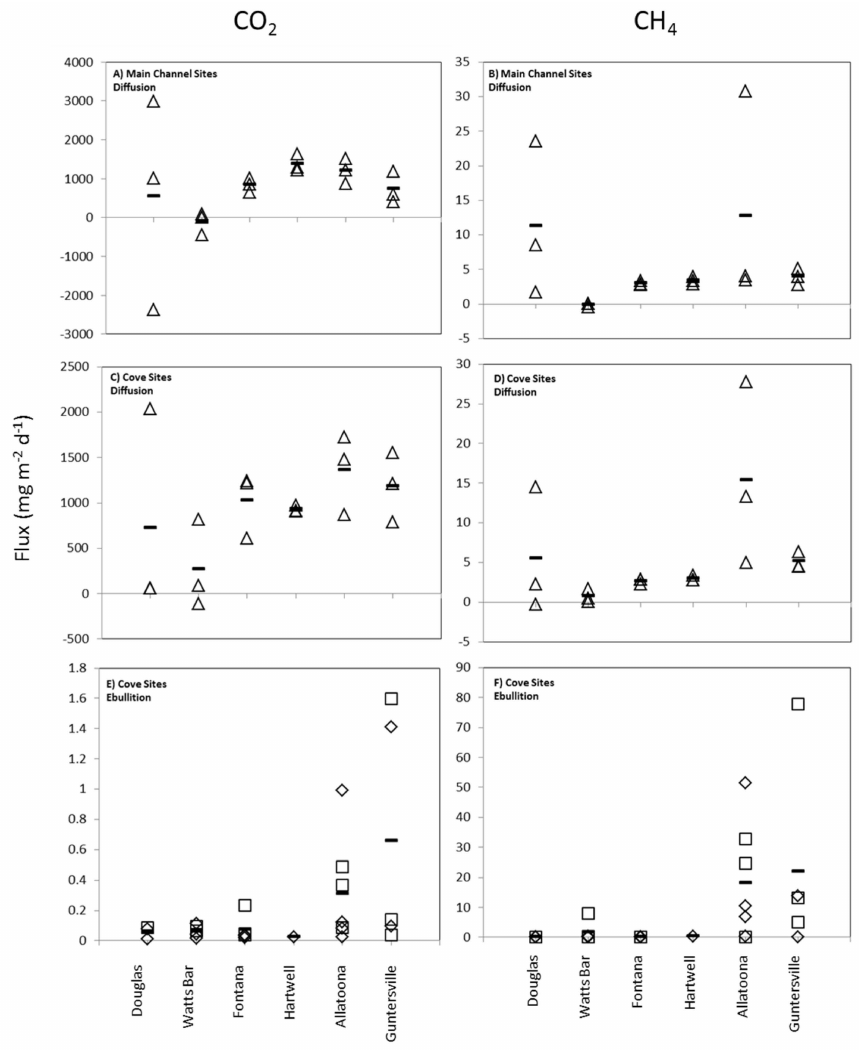
Figure 3. Individual and mean flux measurements of CO 2 and CH 4 from six reservoirs by diffusion at main channel sites ( A , B ); diffusion at cove sites ( C , D ); and ebullition at cove sites ( E , F ). Triangles represent 20-min dome measurements. Diamonds and squares represent overnight funnel measurements at two coves. Mean values are indicated with a